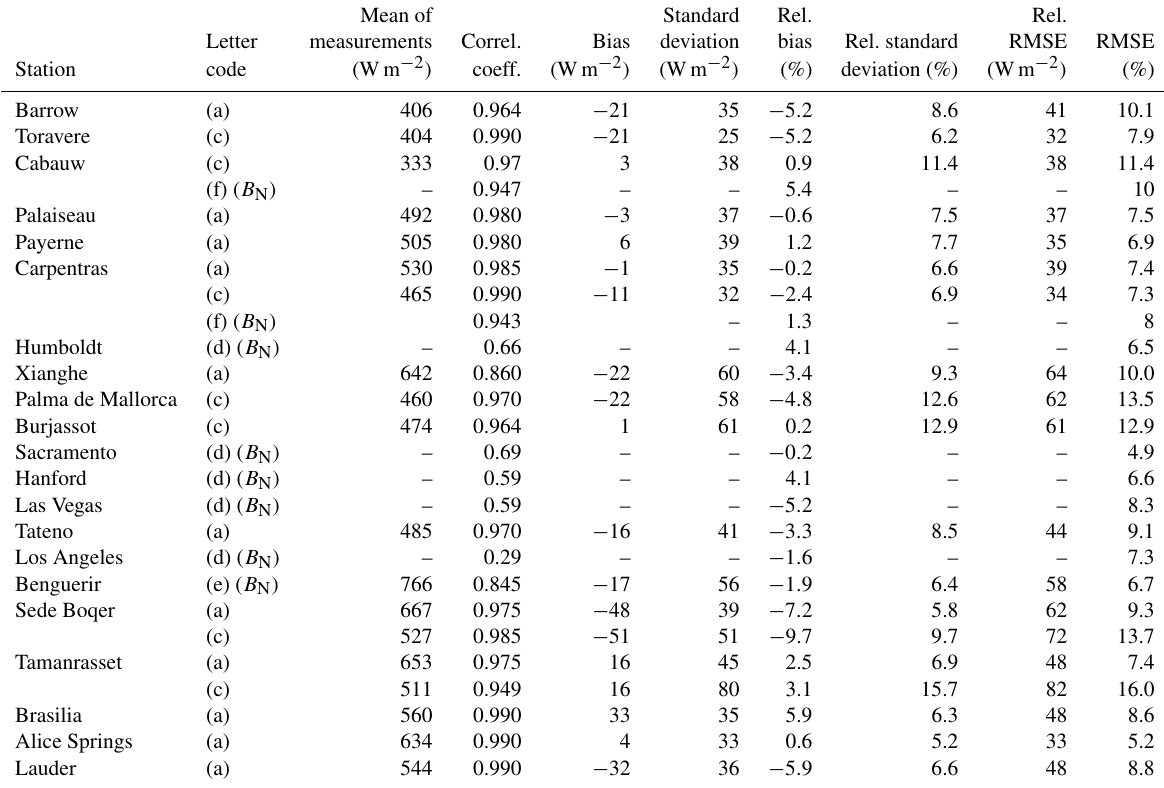
Table B4. Results from previous works at summarization 1min. Means of the measurements, correlation coefficients, bias, standard devia- tions, RMSE, and their values relative to the mean of the measurements for B or B N . Mean of Standard Rel.